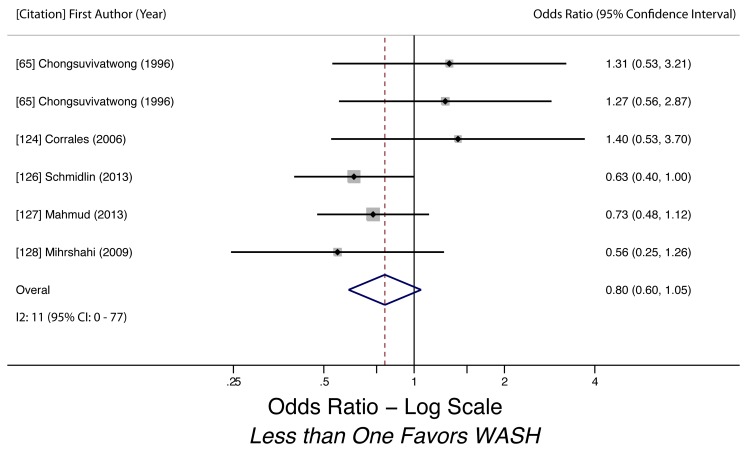
Meta-analysis of the association between sanitation access and hookworm infection [65],[124],[126]–[128]. Note: Chongsuvivatwong et al [65]. reported on two separate studies in their 1996 article.